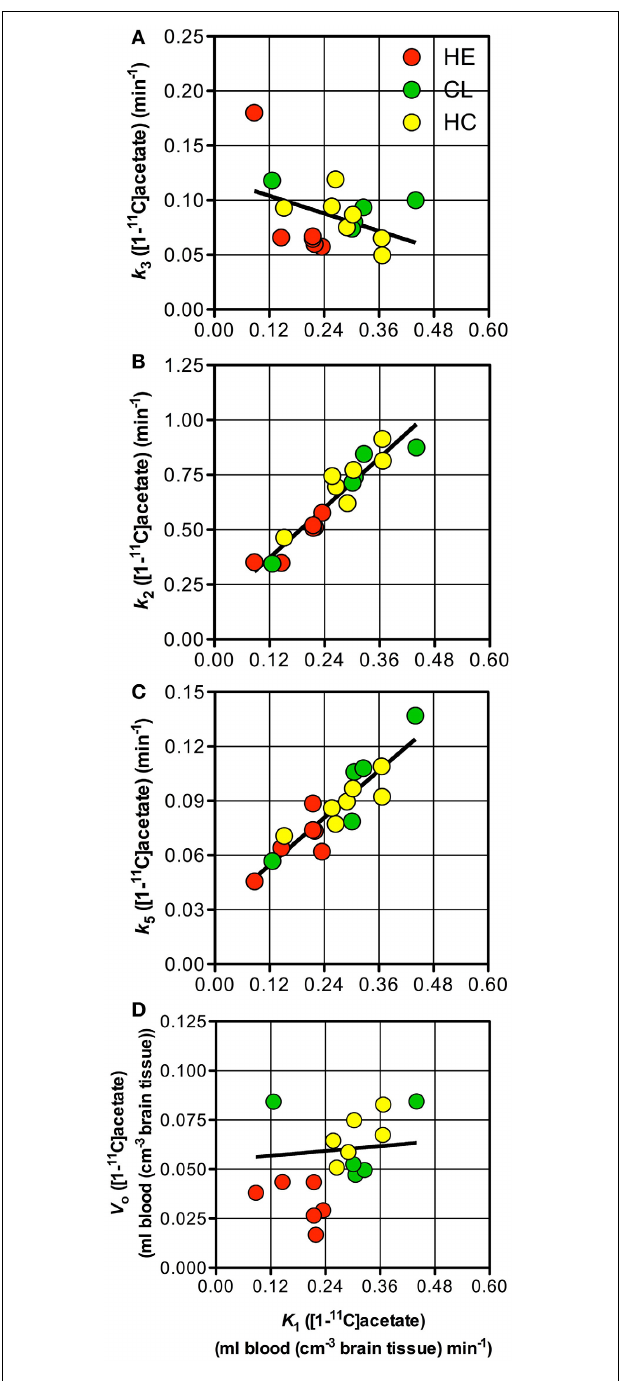
FIGURE 3 | Individual parameter estimates. Patients with cirrhosis and hepatic encephalopathy (HE) ( ), patients with cirrhosis without HE ( ), and healthy subjects ( ). (A) Rate constant of whole brain astrocyte oxidative metabolism, k 3 vs. unidirectional clearance from blood-to-brain tissue of [ 11 C]acetate, K 1 . (B) Rate constant for return of [ 11 C]acetate from the astrocytes to blood, k 2 vs. K 1 . (C) Passive diffusion of [ 11 C]CO 2 from the astrocytes into the blood, k 5 vs. K 1 . (D) Apparent distribution volume in vascular space, V 0 vs. K 1 . Solid line indicates a